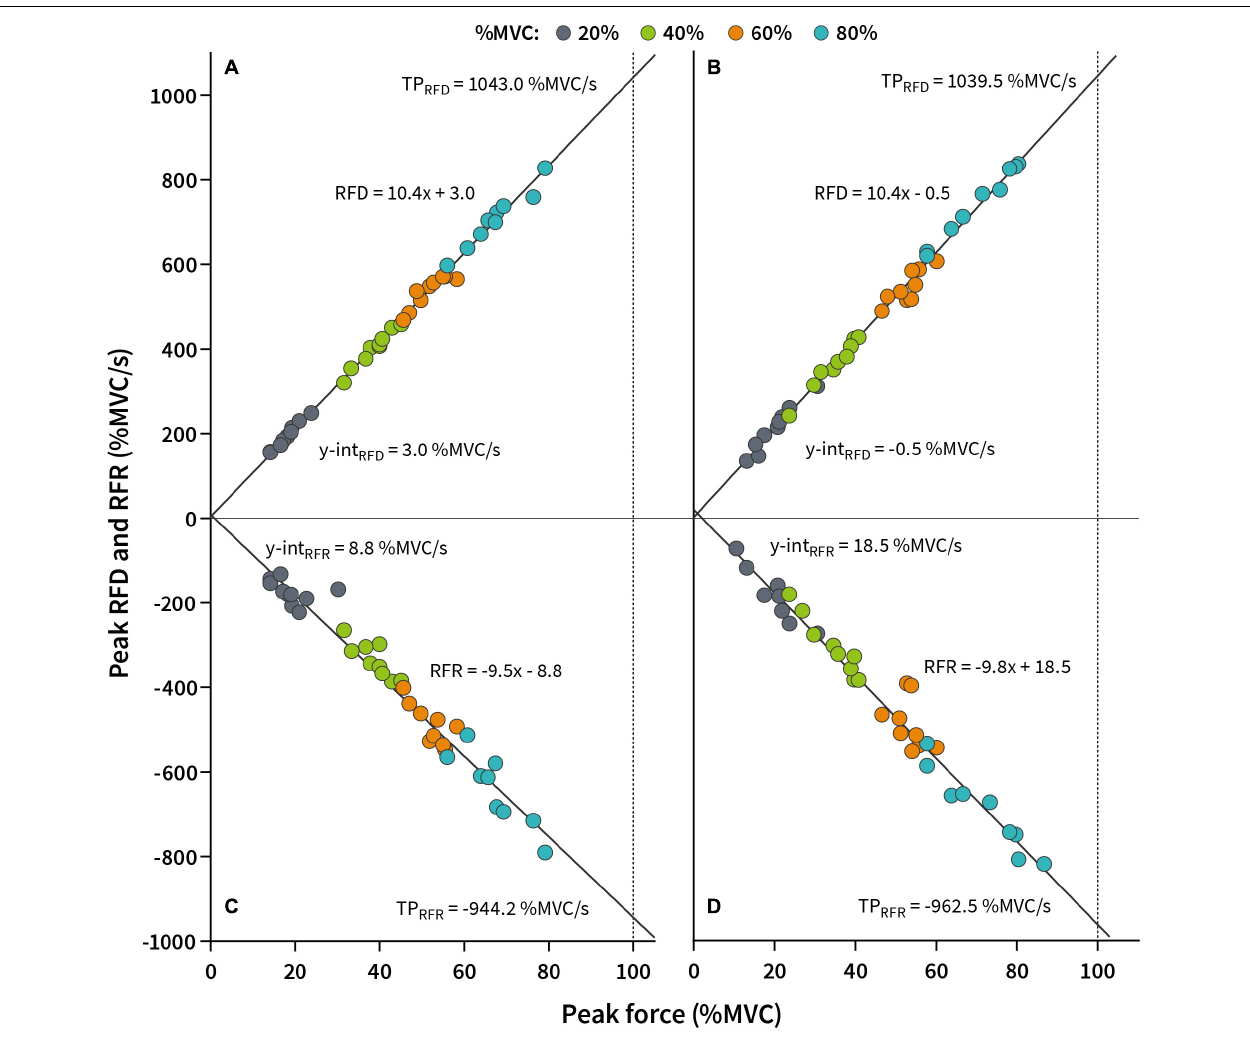
FIGURE 2 | The slope of the rate of force development/relaxation scaling factor (k RFD − SF /k RFR − SF ) of a representative participant interpolated to a data scatter. (A) Scatter plot and regression line of the nine randomly selected pulses at each submaximal level used for calculation of the k RFD − SF . (B) Scatter plot and regression line of the remaining nine randomly selected pulses (after the first selection) at each submaximal level used to calculate the k RFD − SF . (C) Scatter plot and regression line of the nine randomly selected pulses at each submaximal level used to calculate the k RFR − SF . (D) Scatter plot and regression line of the remaining nine randomly selected pulses at each submaximal level used for calculation of the k RFR − SF . k RFD − SF , slope of the rate of force development scaling factor; k RFR − SF , slope of the rate of force relaxation scaling factor; y-int RFD , y-intercept of RFD-SF; y-int RFR , y-intercept of RFR-SF; TP RFD , theoretical peak rate of force development; TP RFR , theoretical peak rate of force